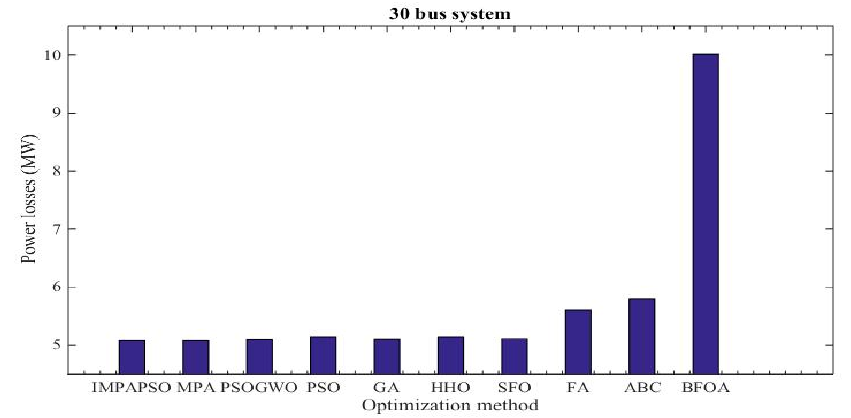
Figure 5. Power losses obtained by different optimization methods for 30 bus system. Table 2. 30-bus system decision variables for the first case.